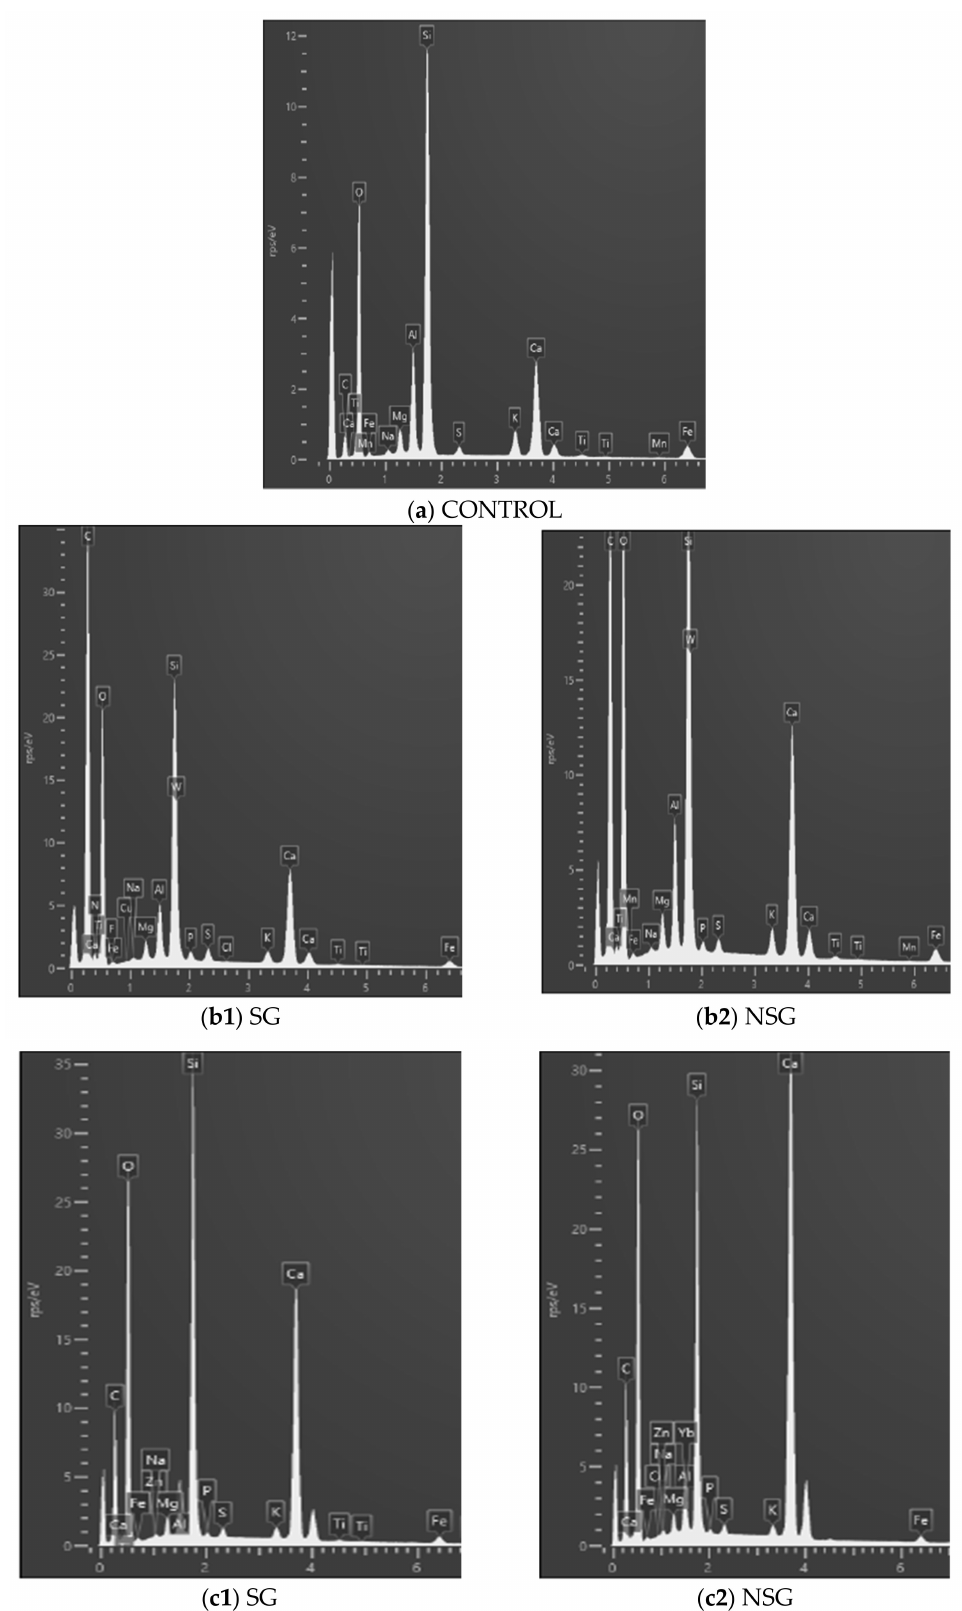
Figure 7. EDS spectra of control (untreated) ( a ), biopolymers before performing the Karsten tube test ( b ) and after the Karsten tube test ( c